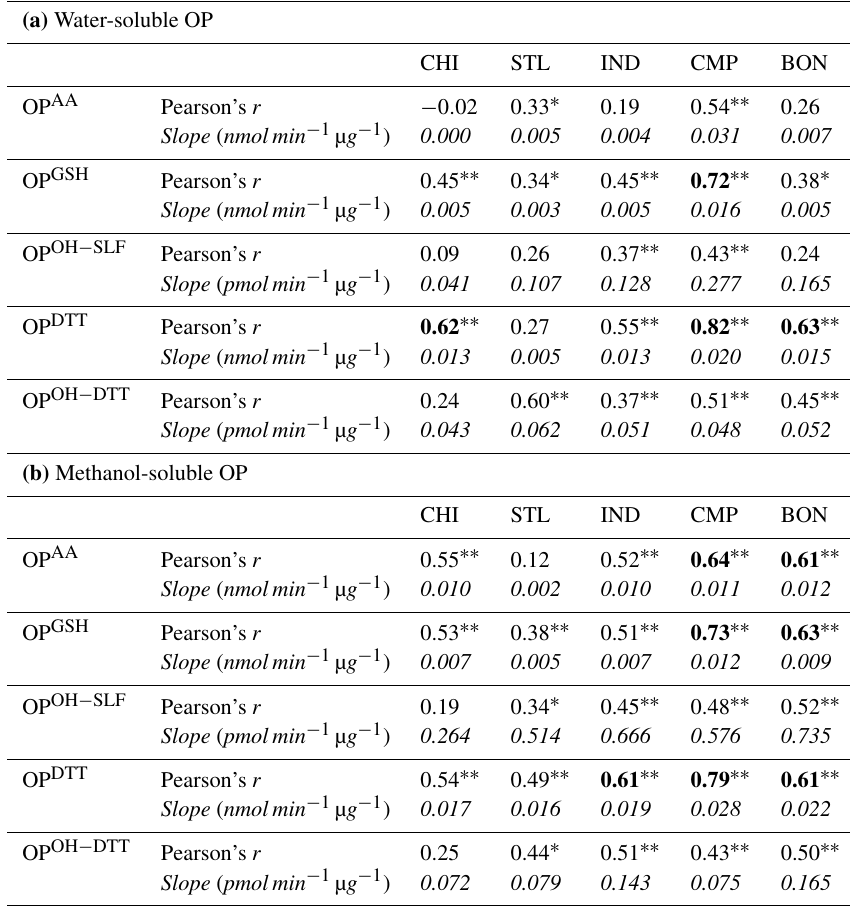
Table 4. Pearson’s r and slope for simple linear regression of water-soluble OPv versus PM 2 . 5 mass concentration at five sampling sites. Correlations with r > 0 . 60 are shown in bold. All slope values are in italic. Single asterisks ∗ and double asterisks ∗∗ indicate significant ( P < 0 . 05) and highly significant ( P < 0 . 01) correlations,